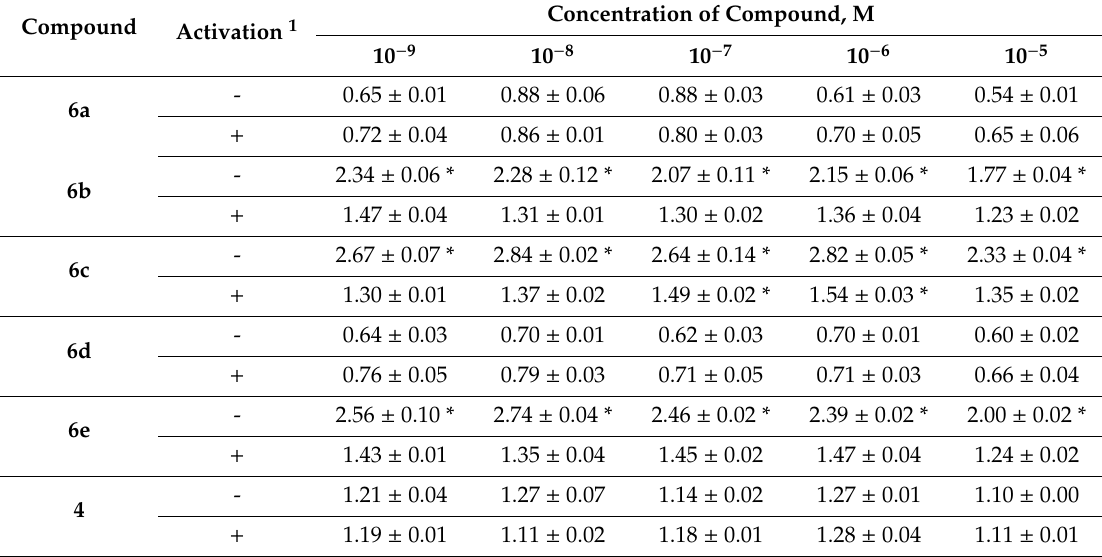
Table 6. Genotoxicity (induction factor, I) of the pyrrolidine-1-carboxamides possessing a benzofuroxan moiety registered with the bacterial lux-biosensor Escherichia coli MG1655 (pRecA-lux). Compound